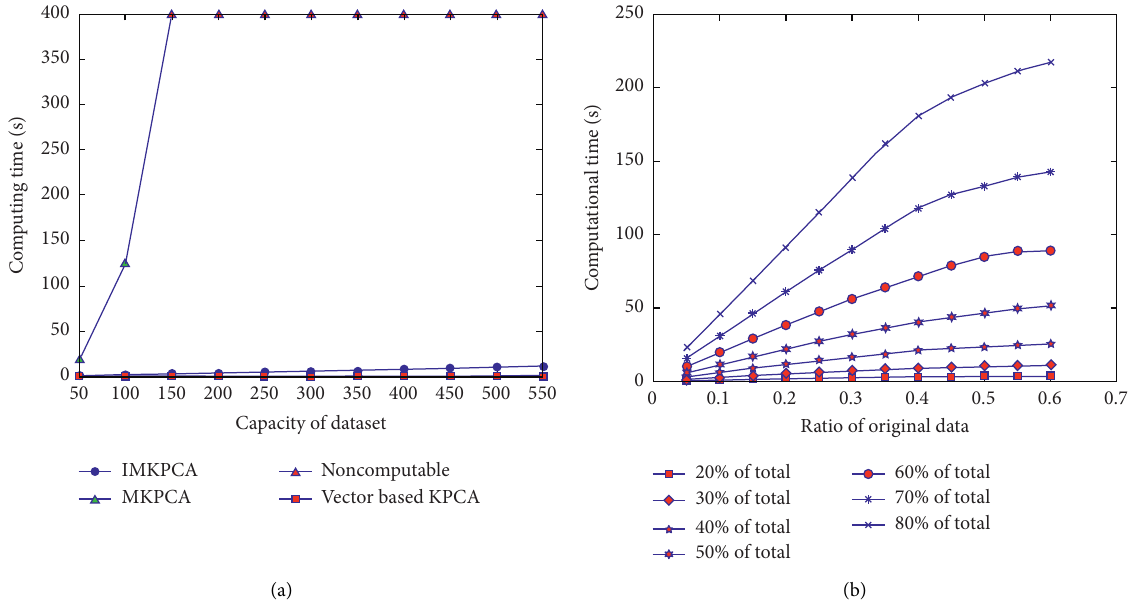
Figure 9: Computing time for Fashion MNISTdatabase. (a) Computational time under different capacities. Red triangle denotes situations where computing time is longer than 400 seconds in addition to memory overflow on 4G RAM, 3.2 GCPU. (b) Computational time under different ratio of original